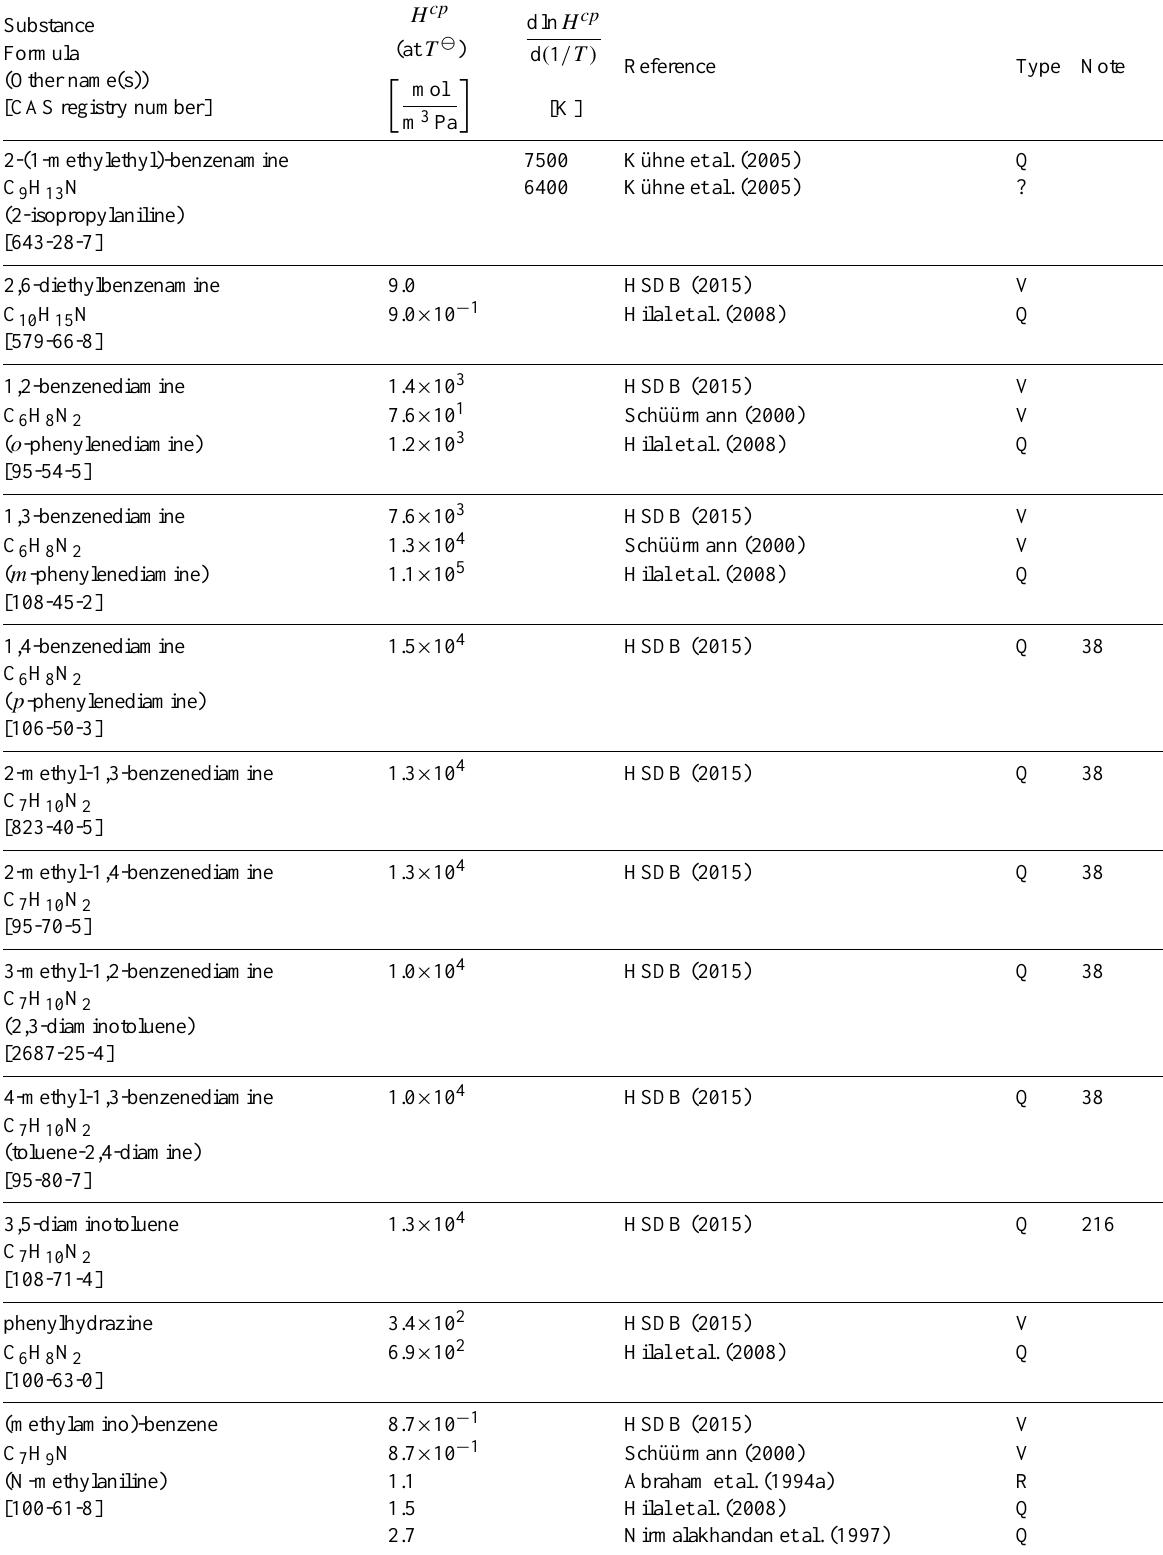
Table 6: Henry’s law constants for water as solvent